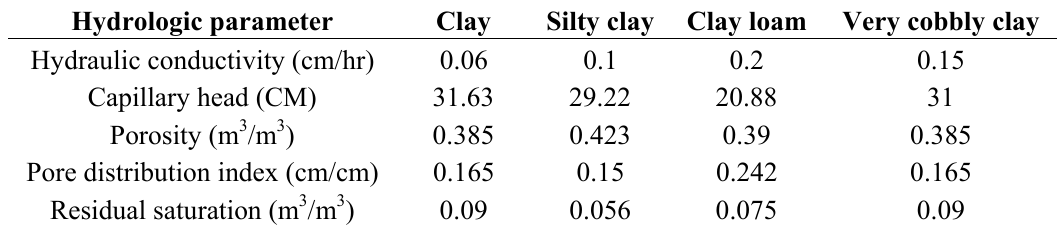
Table 3. Soil hydrologic properties used in the study.